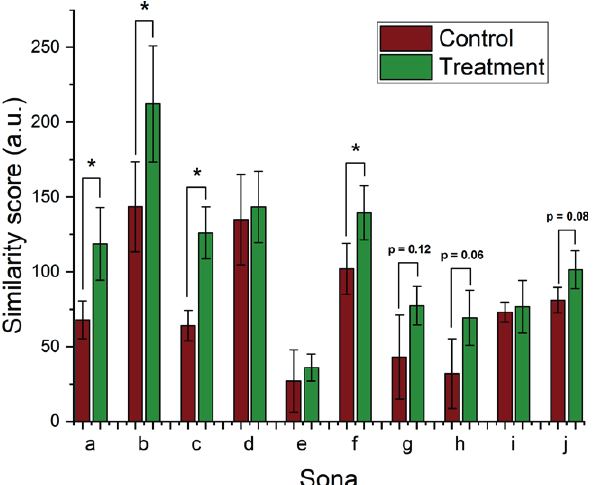
Figure 9. Comparison of similarity scores for diff erent sona pat- terns and two cell populations, one that was left intact (control, wine) and one that was subjected to the nanoparticle therapy (treat- ment, green). Individual bars are data points representing averages (n = 3 x 3), while error bars represent the standard deviation. Data points statistically signifi cantly diff erent (p < 0.05) with respect to one another are connected with an asterisk. Comparative data points whose diff erence displayed moderate levels of statistical sig- nifi cance are connected with exact p-values. Th e reader is referred to Fig.6 for the identifi cation of sona patterns marked with (a) through (j).